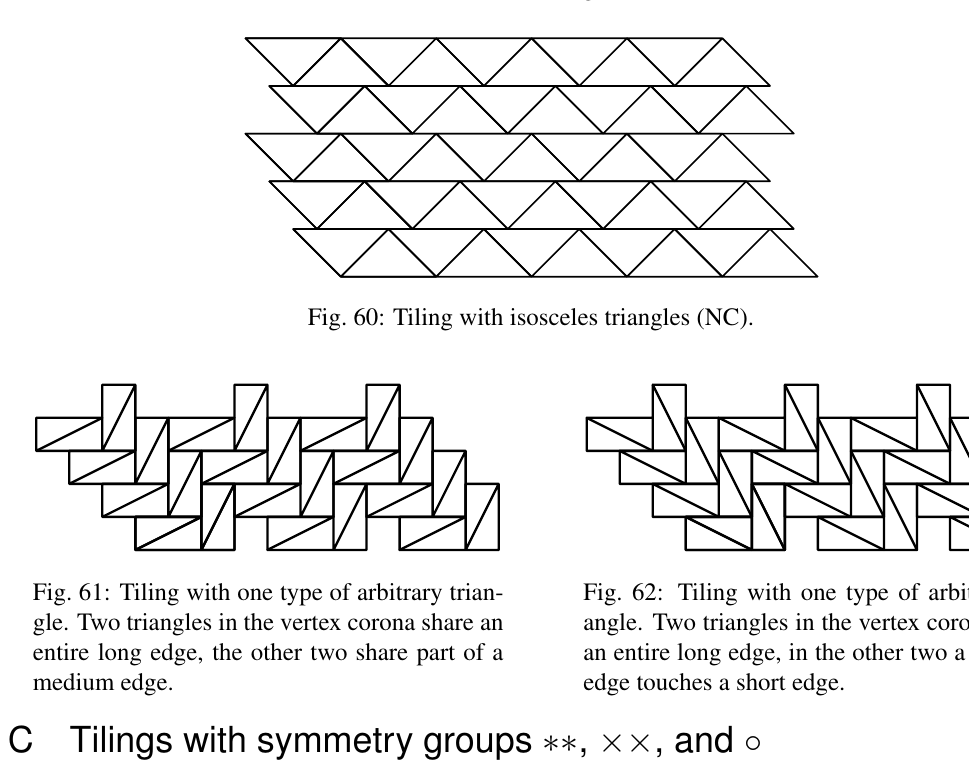
Fig. 59: Tiling with one type of arbitrary trian- gle but odd rows are reflected.